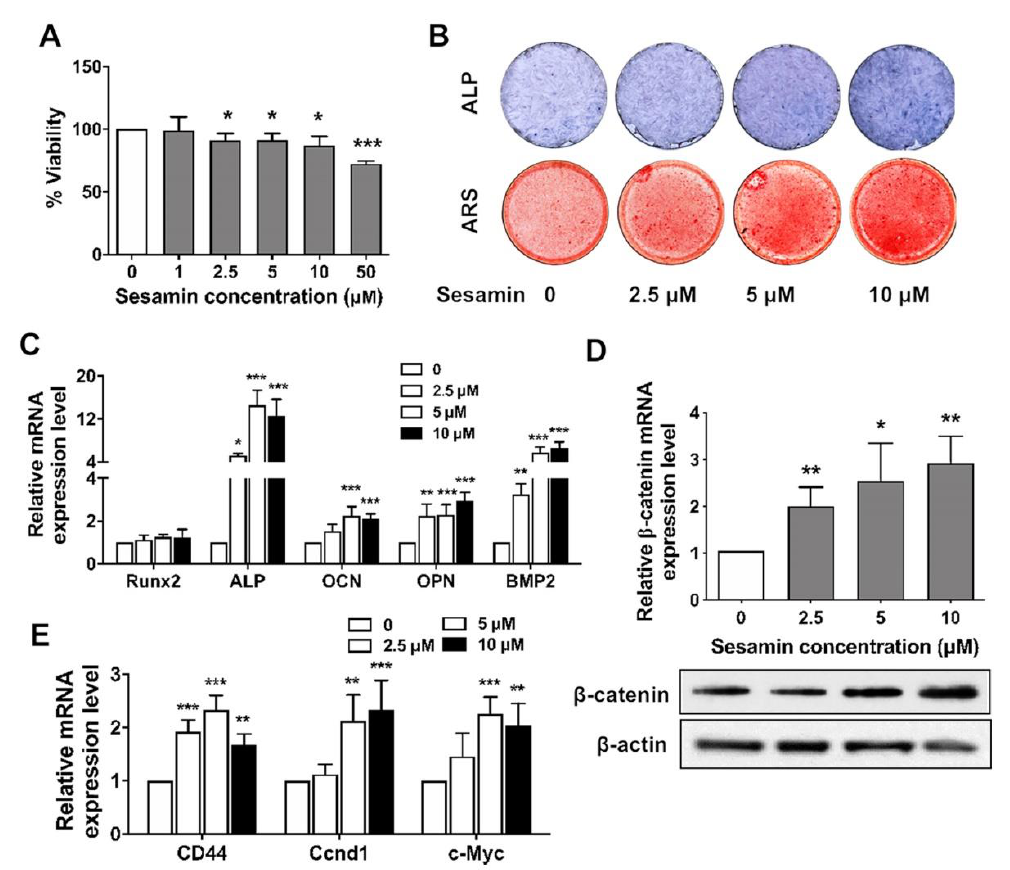
Figure 2. Sesamin promoted BMSCs osteogenesis via up-regulating Wnt/ β -catenin signaling pathway. ( A ). Cytotoxicity assay of mouse BMSCs after treated with sesamin at different concentration for 3 days ( n = 6; * p < 0.05, *** p < 0.001). ( B ) . The ALP staining at Day 3 and the ARS staining of calcified nodules at Day 7 after osteo-induction were performed. ( C ) . The mRNA expression level of osteogenic marker genes were detected by quantitative real-time PCR after treatment with sesamin after osteo-induction for 7 days ( n = 6; * p < 0.05, ** p < 0.01, *** p < 0.001). ( D ) . Sesamin up-regulated the expression of β -catenin in mouse BMSCs at both mRNA and protein expression levels ( n = 6; * p < 0.05, ** p < 0.01). ( E ) . The mRNA expression level of Wnt/β -catenin downstream genes in mouse BMSCs were significantly increased after sesamin treatment at different concentrations ( n = 6; ** p < 0.01, *** p < 0.001).